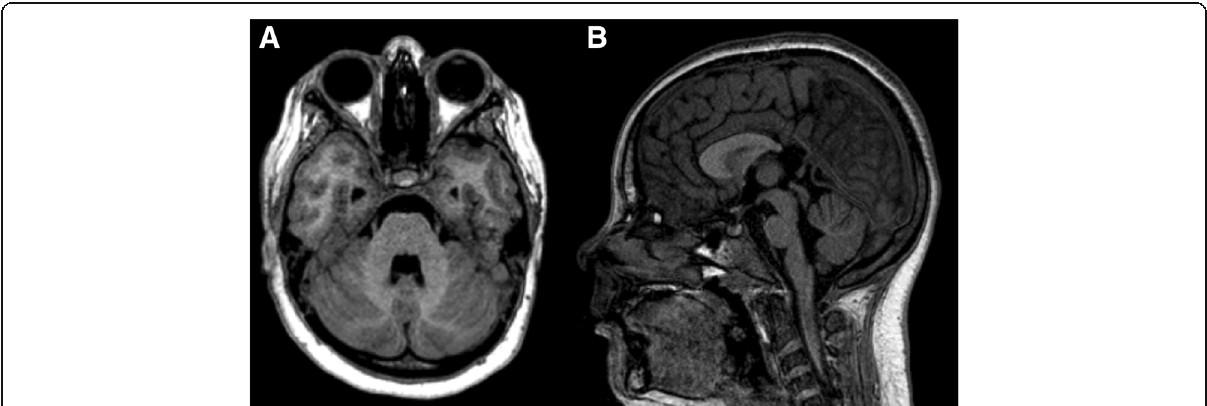
Fig. 9 Axial ( a ) and sagittal ( b ) T1/3D of a 12-year-old girl with Down syndrome, showing small brainstem structures with enlargement of the IV ventricle. In particular, there is a reduced cranio-caudal diameter of the pons. Also, the agenesis of the splenium of corpus callosum, a finding